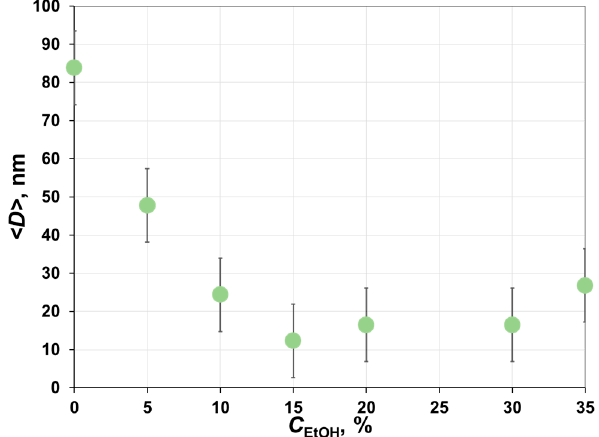
Figure 9. Effect of ethanol concentration in casting solution on the average diameter of transport pores of membranes.